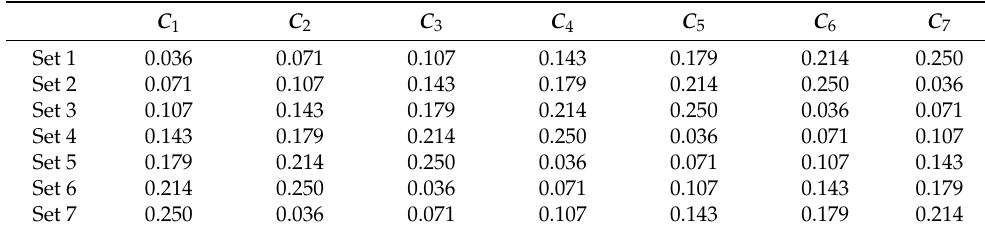
Table 8. The criteria weights for sensitivity analysis